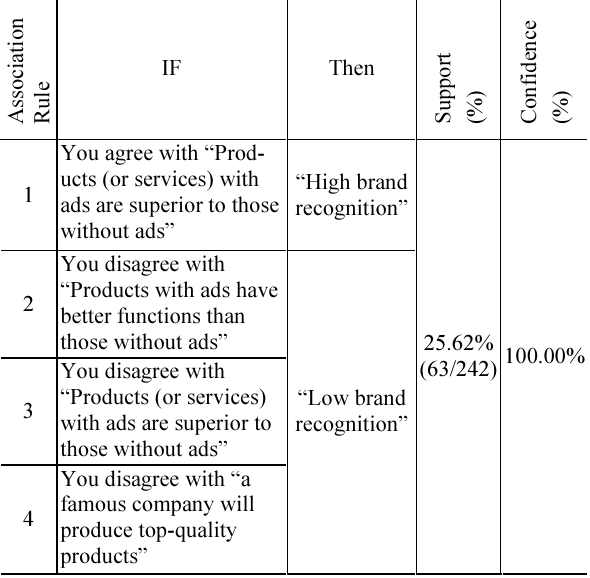
Fig. 2. Analytical Results of Decision Tree for selecting firms with brand